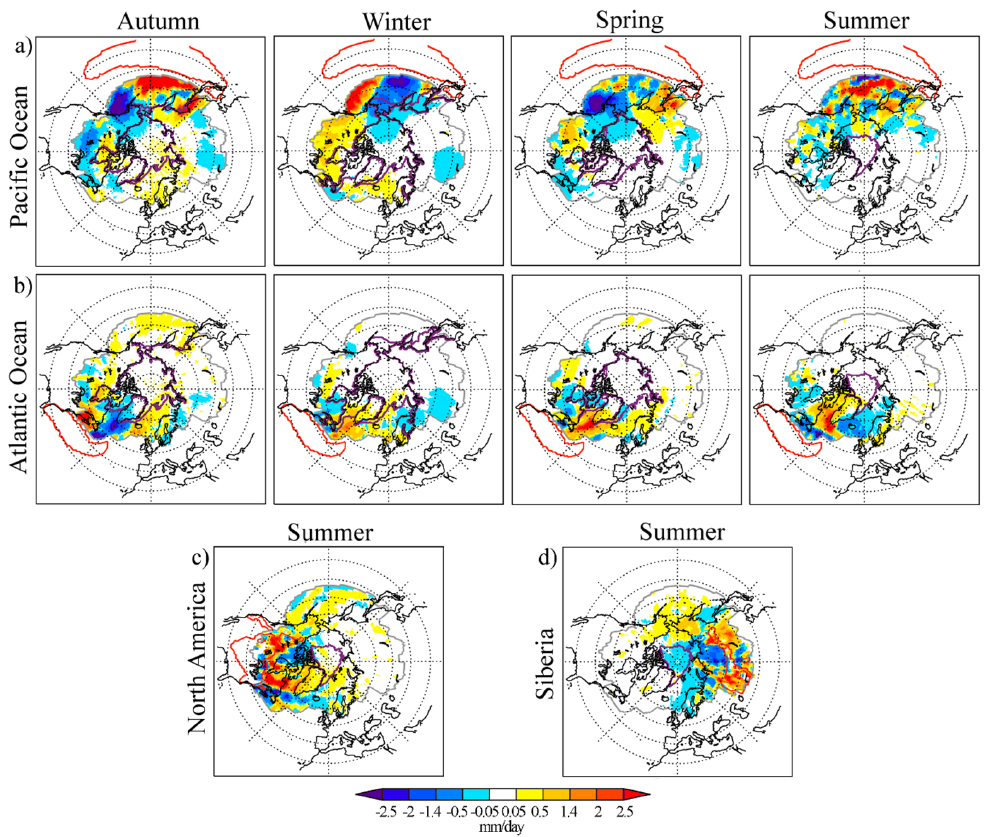
Figure 7. Seasonal (E–P) < 0 anomalies for 2011/2012 in the forward experiment from ( a ) the Pacific Ocean ( b ) the Atlantic Ocean ( c ) North America and ( d ) Siberia. Reddish colours represent areas over which the moisture supply is greater in that year from the selected source (positive anomalies) and bluish colours represent areas where the moisture uptake is lower (negative anomalies). Red contour lines represent climatological moisture sources for the Arctic system. Purple contour lines represent the sea ice extent at the end of every season.